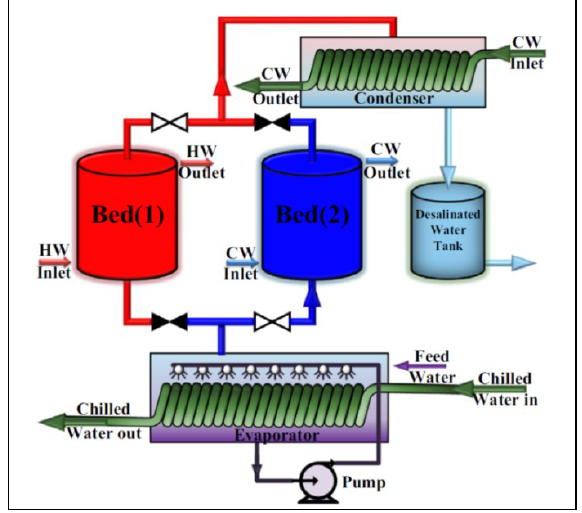
Fig. 1. Diagram of two-bed ADC system with desalination function [ Chyba! Nenalezen zdroj odkazů.